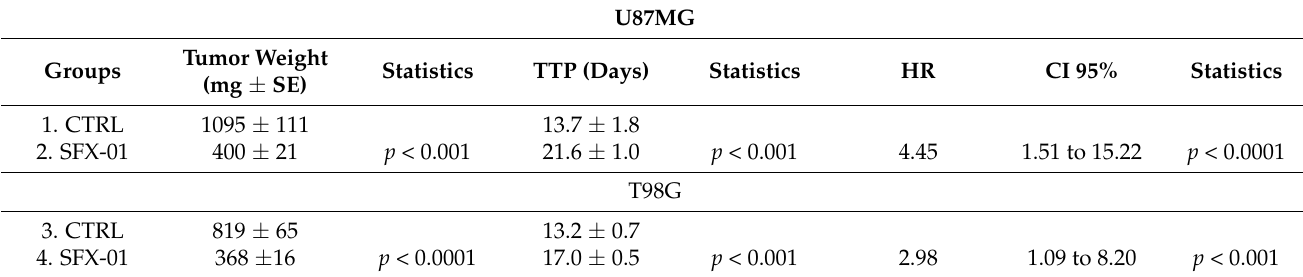
Table 1. Statistical analyses of tumor weight and Time to Progression in U87MG and T98G